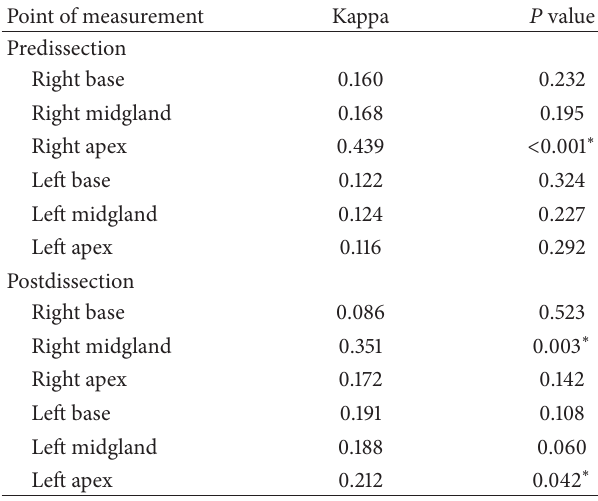
Table 4: Interrater